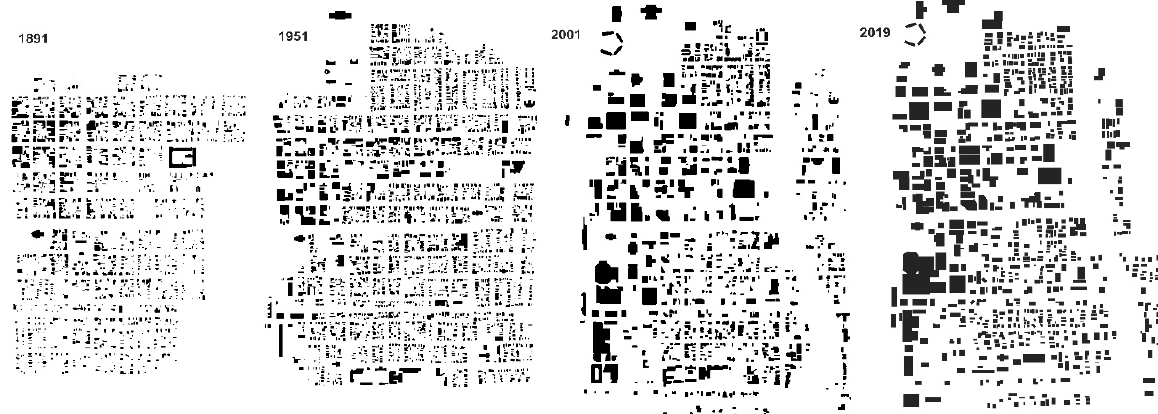
Figure 6. Figure-ground diagrams of downtown and adjacent Baton Rouge areas for 1891, 1951, 2001, and 2019 (for the years 1891, 1952, and 2001 according to Desmond et al. (2005); for the year 2019: own result based on Google Maps orthophotos). In the nearly thirteen decades under consideration, increasing coarseness of building structure becomes clear. The comparison between the structures of the first two years and the last two years of the study clearly shows the impact of Interstate 110 construction (own illustration [37]).